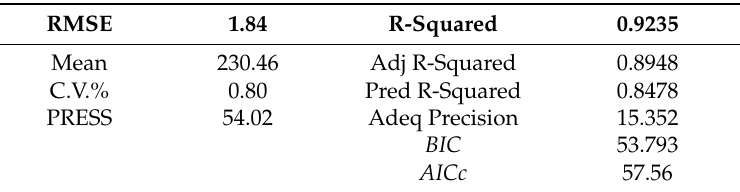
Table 12. Analysis of statistical variance.